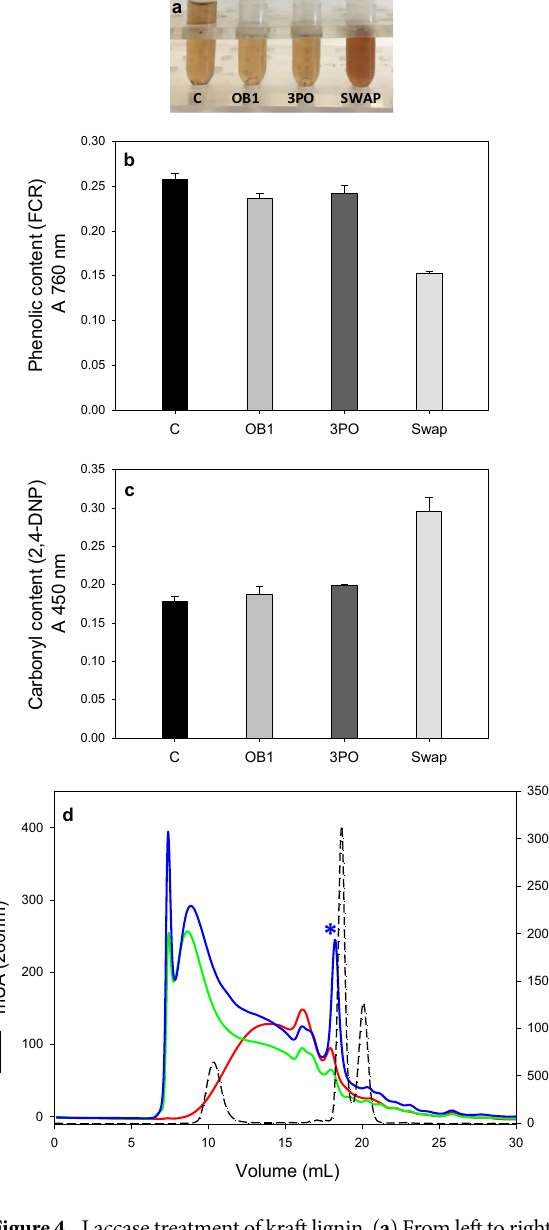
Figure 4. Laccase treatment of kraft lignin. ( a ) From left to right, kraft lignin treated for 1 h at 65 °C, pH 6, without laccase (C) or with OB1, 3PO or domain-swap laccases. ( b ) Phenolic content of treated kraft lignin as determined by A760 nm of the FCR assay. ( c ) Carbonyl content of treated kraft lignin as determined by A 450 nm of the 2,4- DNP assay. ( d ) SEC profile of kraft lignin before (red line) and after treatment with OB1 (green line) or domain- swap (blue line) laccases. Dashed line (from left to right): polystyrene sulfonate (4210 Da), syringaresinol (418 Da) and sinapic acid (224 Da) used as standards (Abs. 260